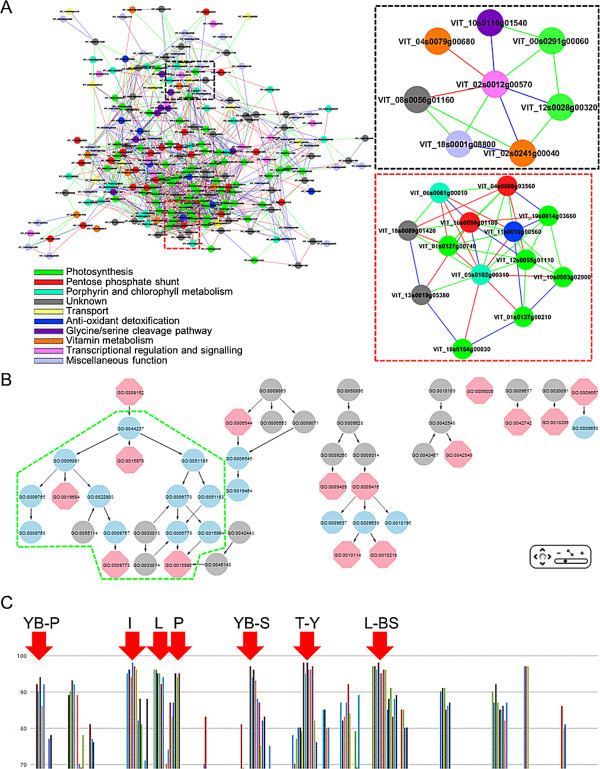
Predicted module involved in photosynthesis (Module All_MCL_6). (A) Output for module ‘All_MCL_6’, which contains 240 nodes and 1419 edges, with genes encoding proteins predominantly involved in photosynthesis (green), pentose-phosphate pathway (red), porphyrin and chlorophyll metabolism (cyan), transport (yellow), anti-oxidant detoxification (blue) and vitamin metabolism (orange) while others were involved in glycine/serine cleavage pathway (purple), transcriptional regulation and signalling (pink) and miscellaneous functions (light blue). Grey nodes represent genes whose function remains unknown or uncharacterised based on homology searches. Sub-network of putative APRR2 and GUN4 extracted from module ‘All_MCL_6’ within a neighbourhood distance of 1 (i.e. nodes connected directly to the query gene) are highlighted in black and red boxes, respectively. (B) Network representation of truly significant and highly enriched GO:BP terms related to photosynthesis, electron transport and chlorophyll metabolism are highlighted in green boxes. Other enriched GO terms were removed from presentation for clarity. (C) Expression specificity of module ‘All_MCL_6’ showing experiments in which at least 70% of the probesets demonstrated specific expression (Std2Gx > 1.0). YB-P, young berries (pericarp); I, inflorescence; L, leaves; P, petals; YB-S, young berries (skin); T, tendrils (young); L-BS, leaves-biotic stress.